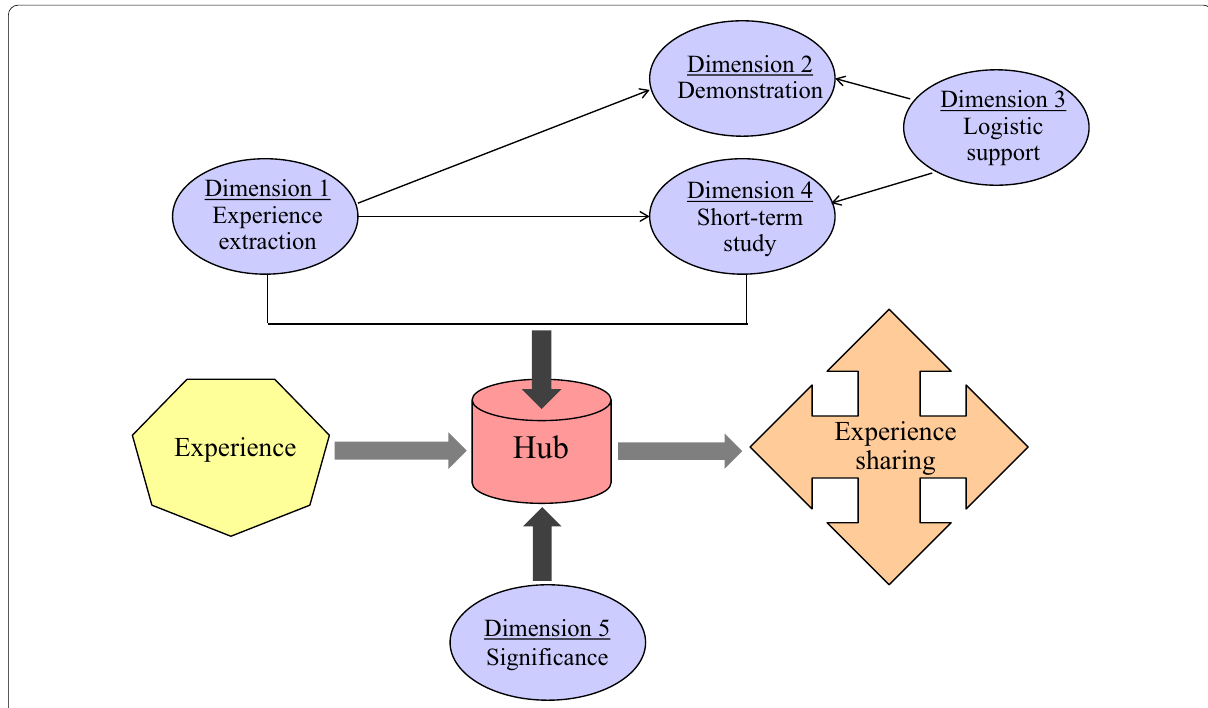
Fig. 1 Framework the hub construction to develop the dimensions of indicator